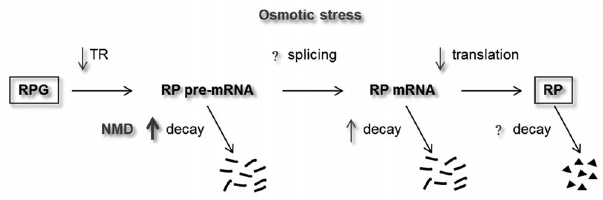
Figure 6. Scheme of the changes in ribosomal protein (RP) gene expression upon osmotic stress. The RP pre-mRNA steady- state depends on both the RP gene transcription rate (TR) by RNA polymerase II and the RP pre-mRNA splicing and degradation rates. The RP mRNA produced by splicing can be used for the synthesis of ribosomal proteins through translation or can be sent to degradation. Osmotic stress provokes a decrease in the RP gene TR and an NMD- dependent increase in the RP pre-mRNA degradation rate. Additionally, osmotic stress increases the RP mRNA degradation rate (lower than the increase in the pre-mRNA degradation rate) and lowers the RP mRNA translation rate. The effect of osmotic stress on RP pre-mRNA splicing and RP decay has not been directly estimated. As a result of these changes, the RP pre-mRNA levels dropped considerably and, to a lesser extent, the RP mRNA level also lowered under osmotic stress. However, RP levels remained constant as a result of the growth inhibition provoked by osmotic stress. See the text for further discussion.